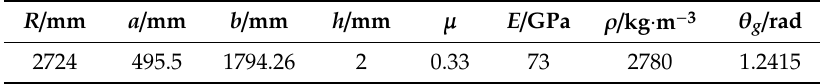
Table 2. Geometric and material property parameters of skin.